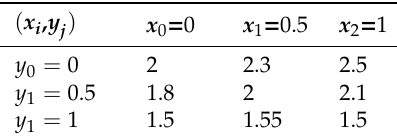
Table 6. Interpolation data.